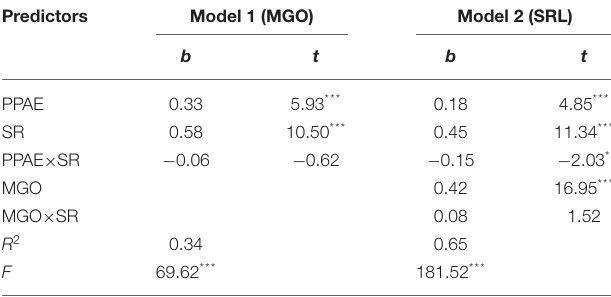
TABLE 4 | Testing the moderated mediation effect of perceived parental academic expectation on SRL